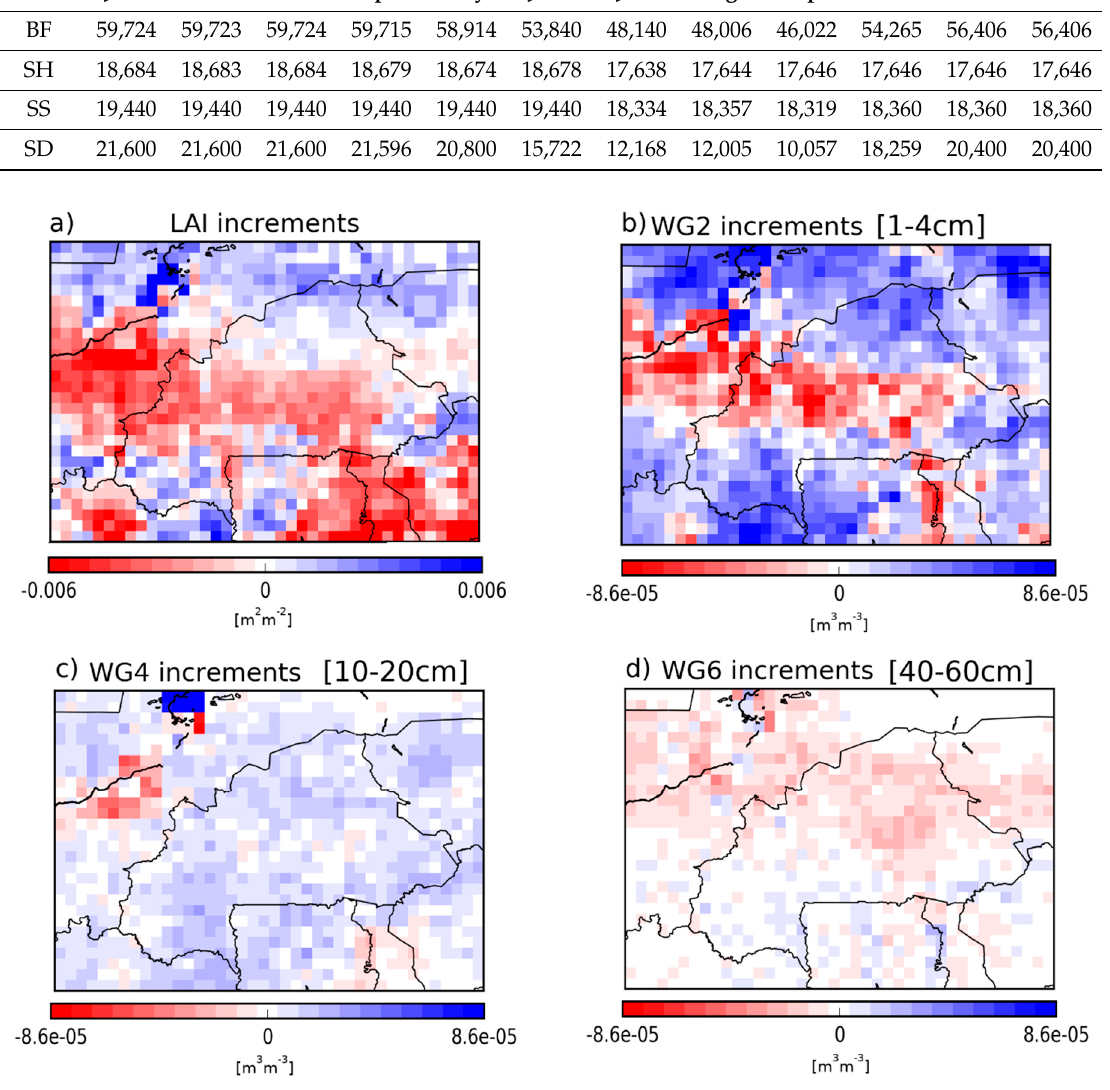
Figure 13. Seasonal correlations for ( a ) anomaly time series between SSM estimates from the CGLS project and SSM from the second layer of soil of ISBA LSM (in blue) and the assimilation (in red) over the period of 2007–06/2018 for both the LDAS-ERA5 and LDAS-ERAI configurations. ( b , c ) Maps of